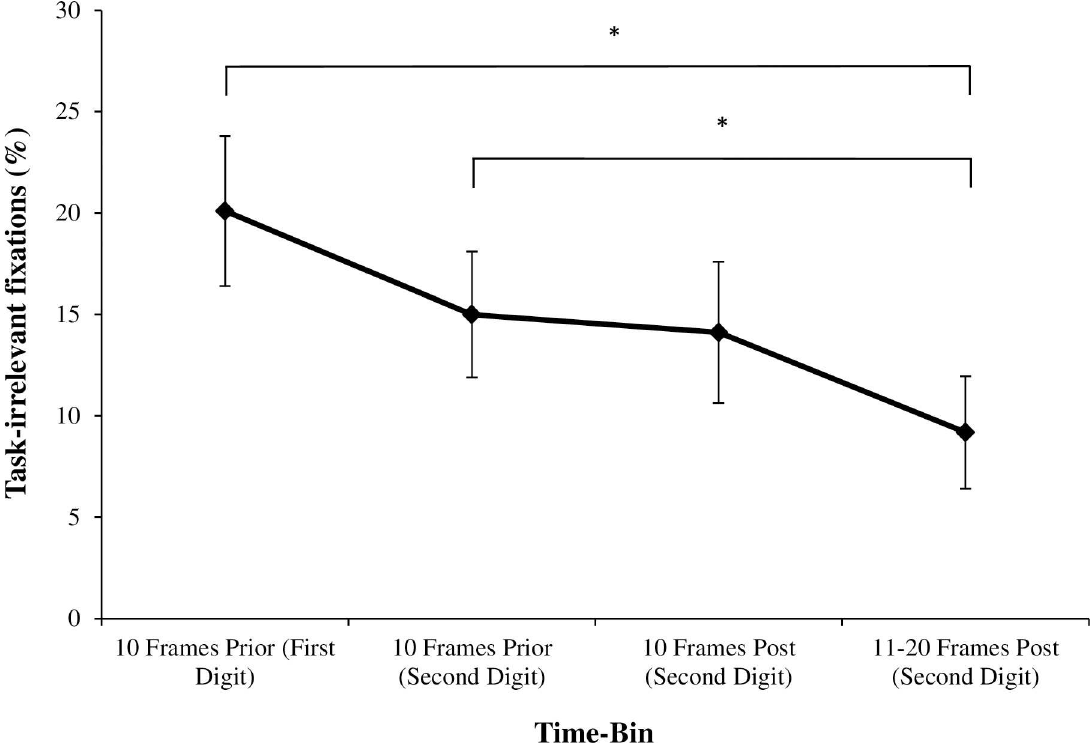
Fig 6. Percentage of time spent fixating task-irrelevant areas (as a %) during different time-bins (mean ± standard error of the mean), * p <